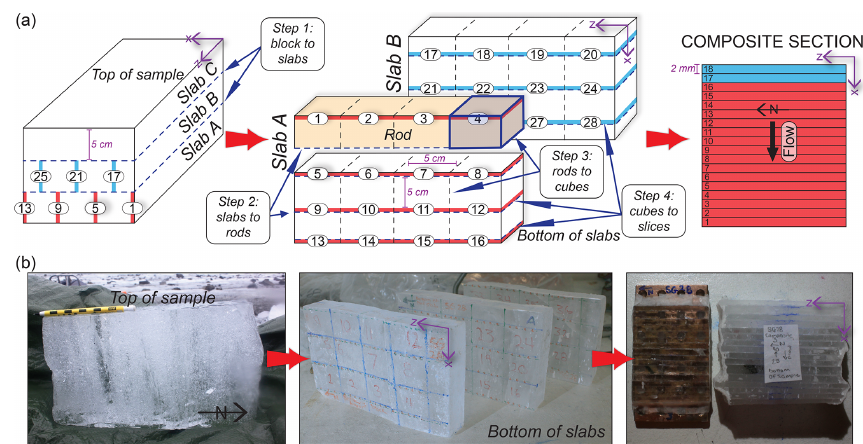
Figure 5. (a) Schematic sample preparation for one composite section. Steps for each cut to progress from sample to slice are specified with dashed lines, and examples of each are highlighted with dark-blue arrows. Individual 2mm slices are shown throughout the process on slab A and slab B, and the numbers correspond to the unique slice in the final composite stack. At least 36 slices were cut from every sample (using slabs A, B and C) to construct composite sections. At least two composites for each sample comprised the final dataset (one composite comprised of slices 1–18 is shown in this figure). (b) Sample preparation illustrated using SG28 from block sample to composite section. Note that the number sequences varied from sample to sample, so the numbers on the slabs do not match the schematic in (a) . Composites are oriented in a kinematic reference frame such that x is the flow or shear direction, y is the vorticity axis, and z is